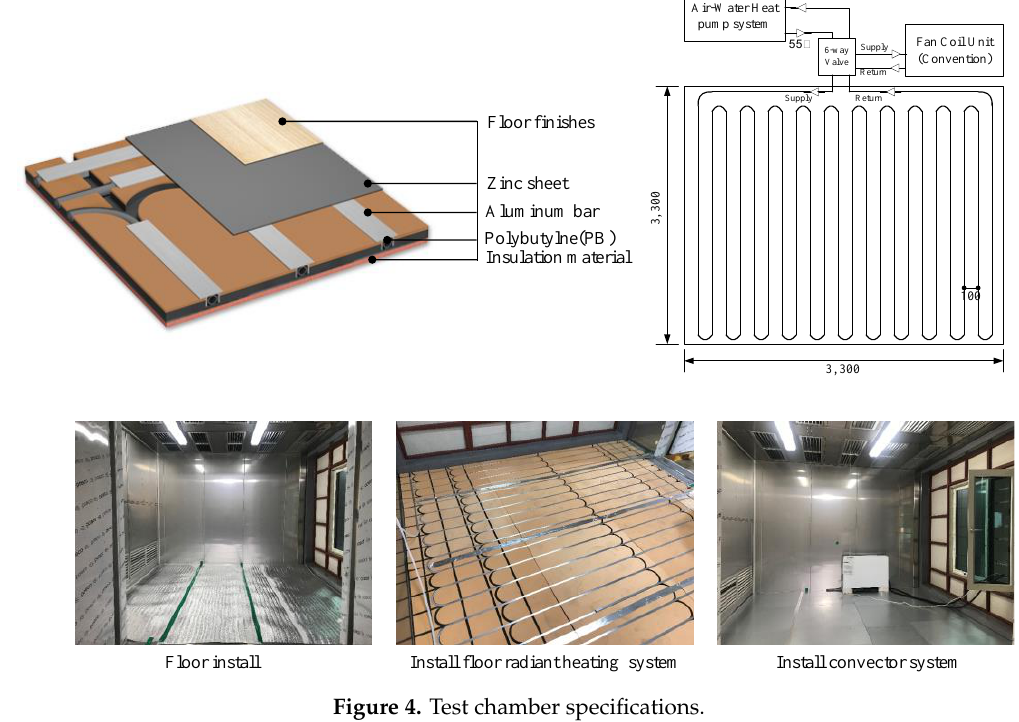
Figure 4. Test chamber specifications. Table 2. Heating system specifications.